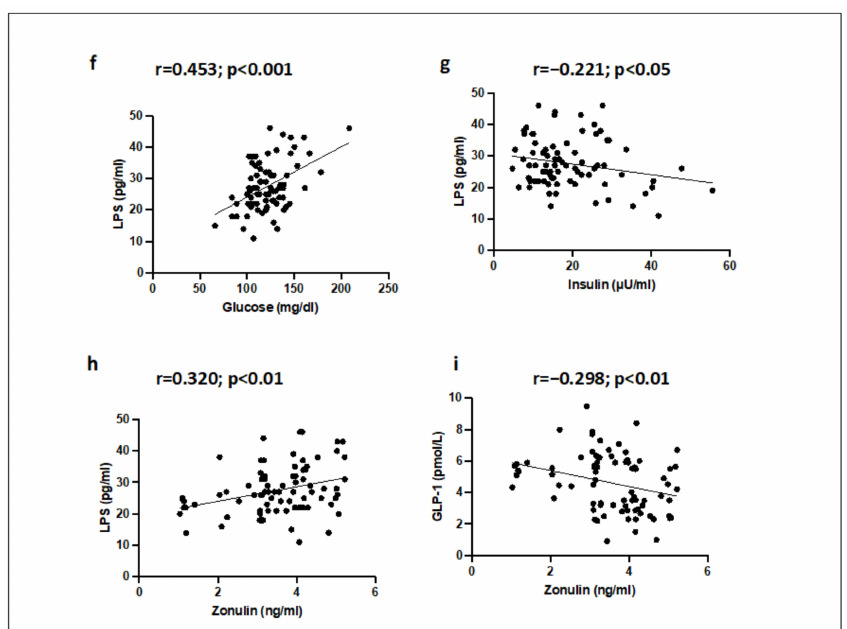
Figure 4. Serum levels of ( a ) glucose, ( b ) insulin, ( c ) GLP-1, ( d ) LPS, and ( e ) zonulin before (T0) and after 2 h (T2h) of oleuropein-enriched chocolate (black line) or control chocolate (grey line) in IFG patients ( n = 20). Correlations of circulating LPS levels with ( f ) glucose, ( g ) insulin, and ( h ) zonulin in patients with IFG. Correlations of circulating zonulin levels with ( i ) GLP-1 in patients with * p <